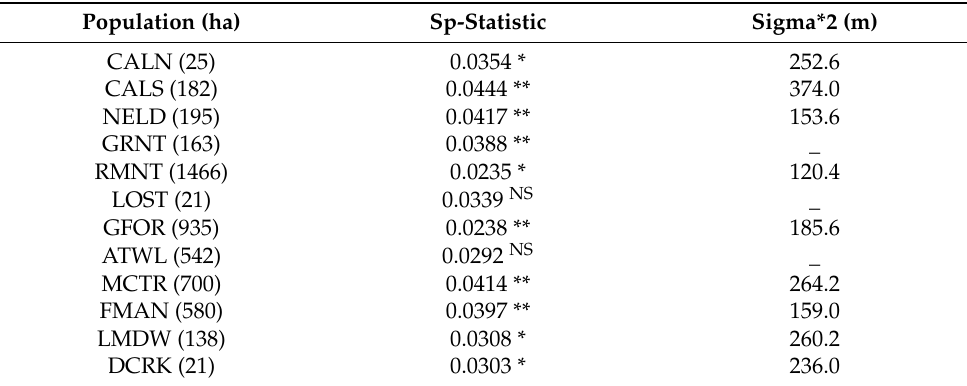
Table 2. Sp-statistic and estimated gene dispersal for twelve giant sequoia populations distributed across the range, based on analyses using SPAGeDi